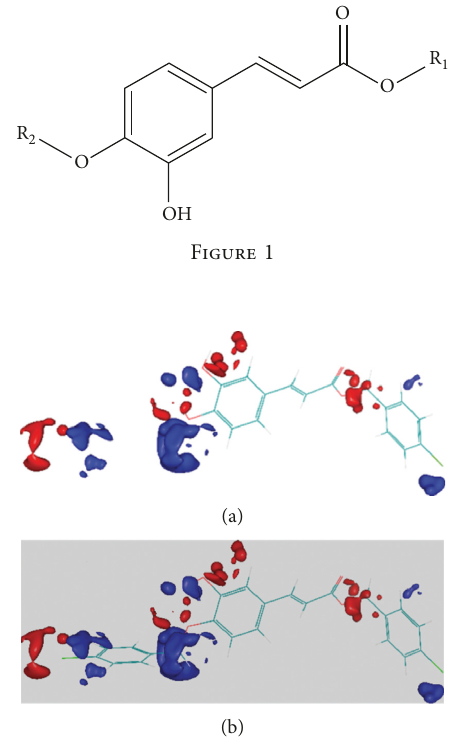
Figure 2: Electrostatic molecular interaction field for compounds 11 and 13 in Escherichia coli.